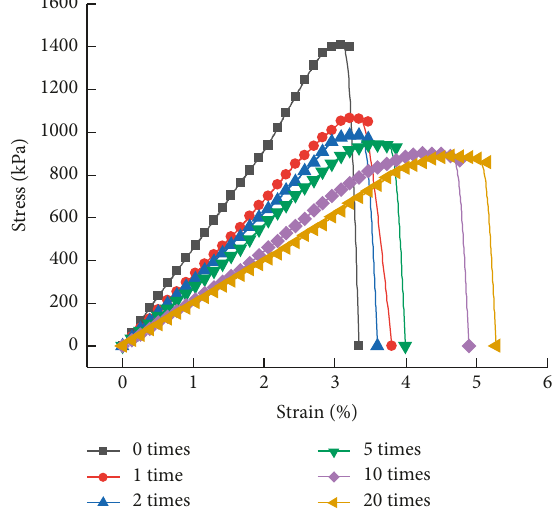
Figure 7: Stress changes with strain: modulus 3.4.